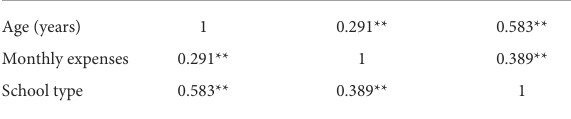
TABLE 4 Spearman correlation analysis among the main